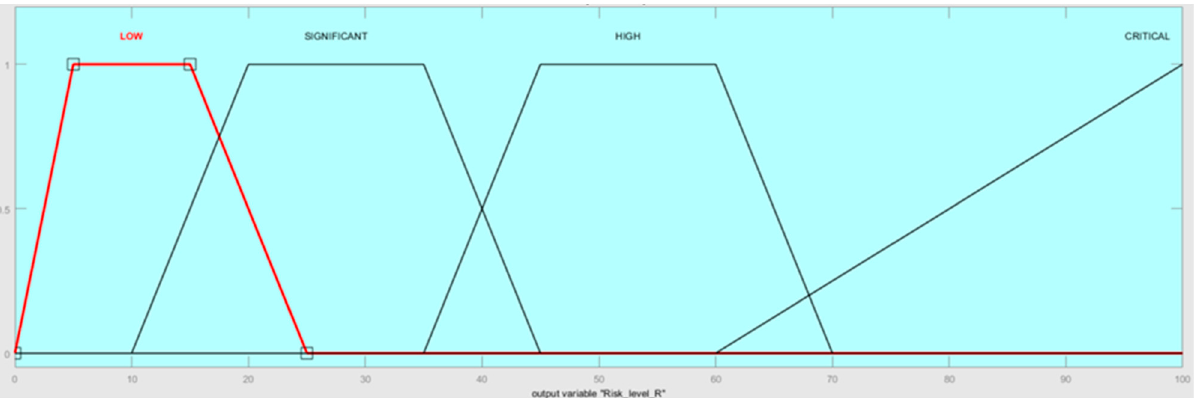
Figure 7. The class of attention fuzzy sets.